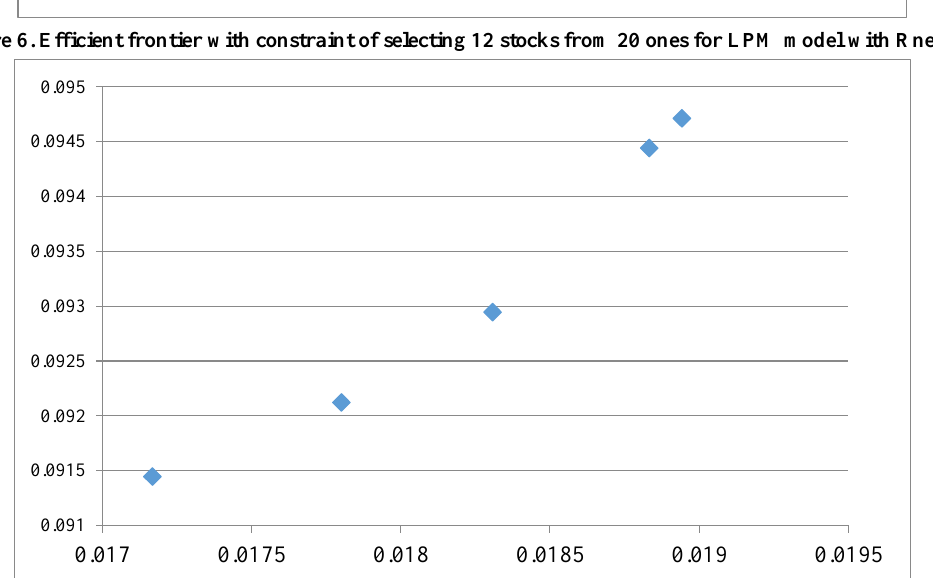
Figure 7. Efficient frontier with constraint of selecting 14 stocks from 20 ones for LPM model with Rnec=